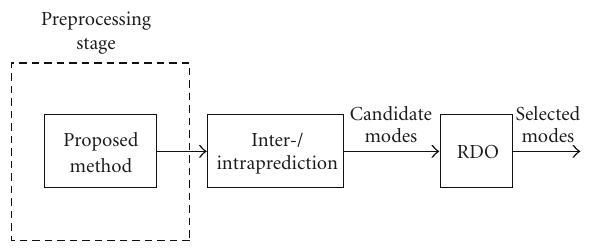
Figure 3: Proposed inter mode prediction for the H.264/AVC.